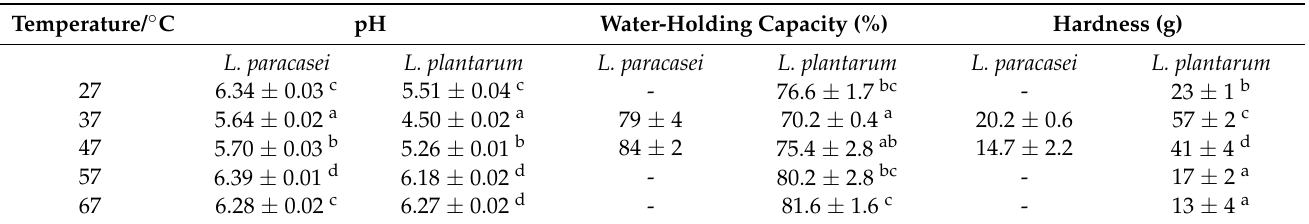
Table 1. Effect of different temperatures on properties of tofu gelatin induced by coagulants fermented using L. paracasei and L. plantarum .